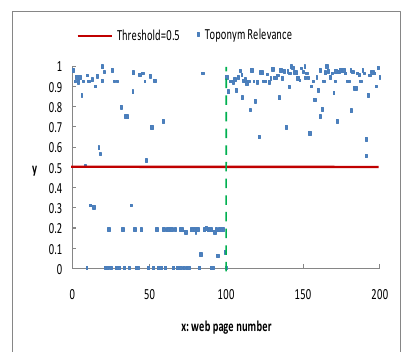
Figure 8 Toponym Relevance in proposed